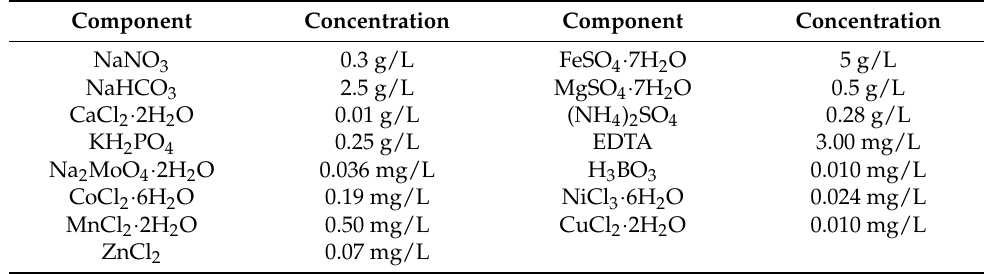
Table 1. Composition of the basal